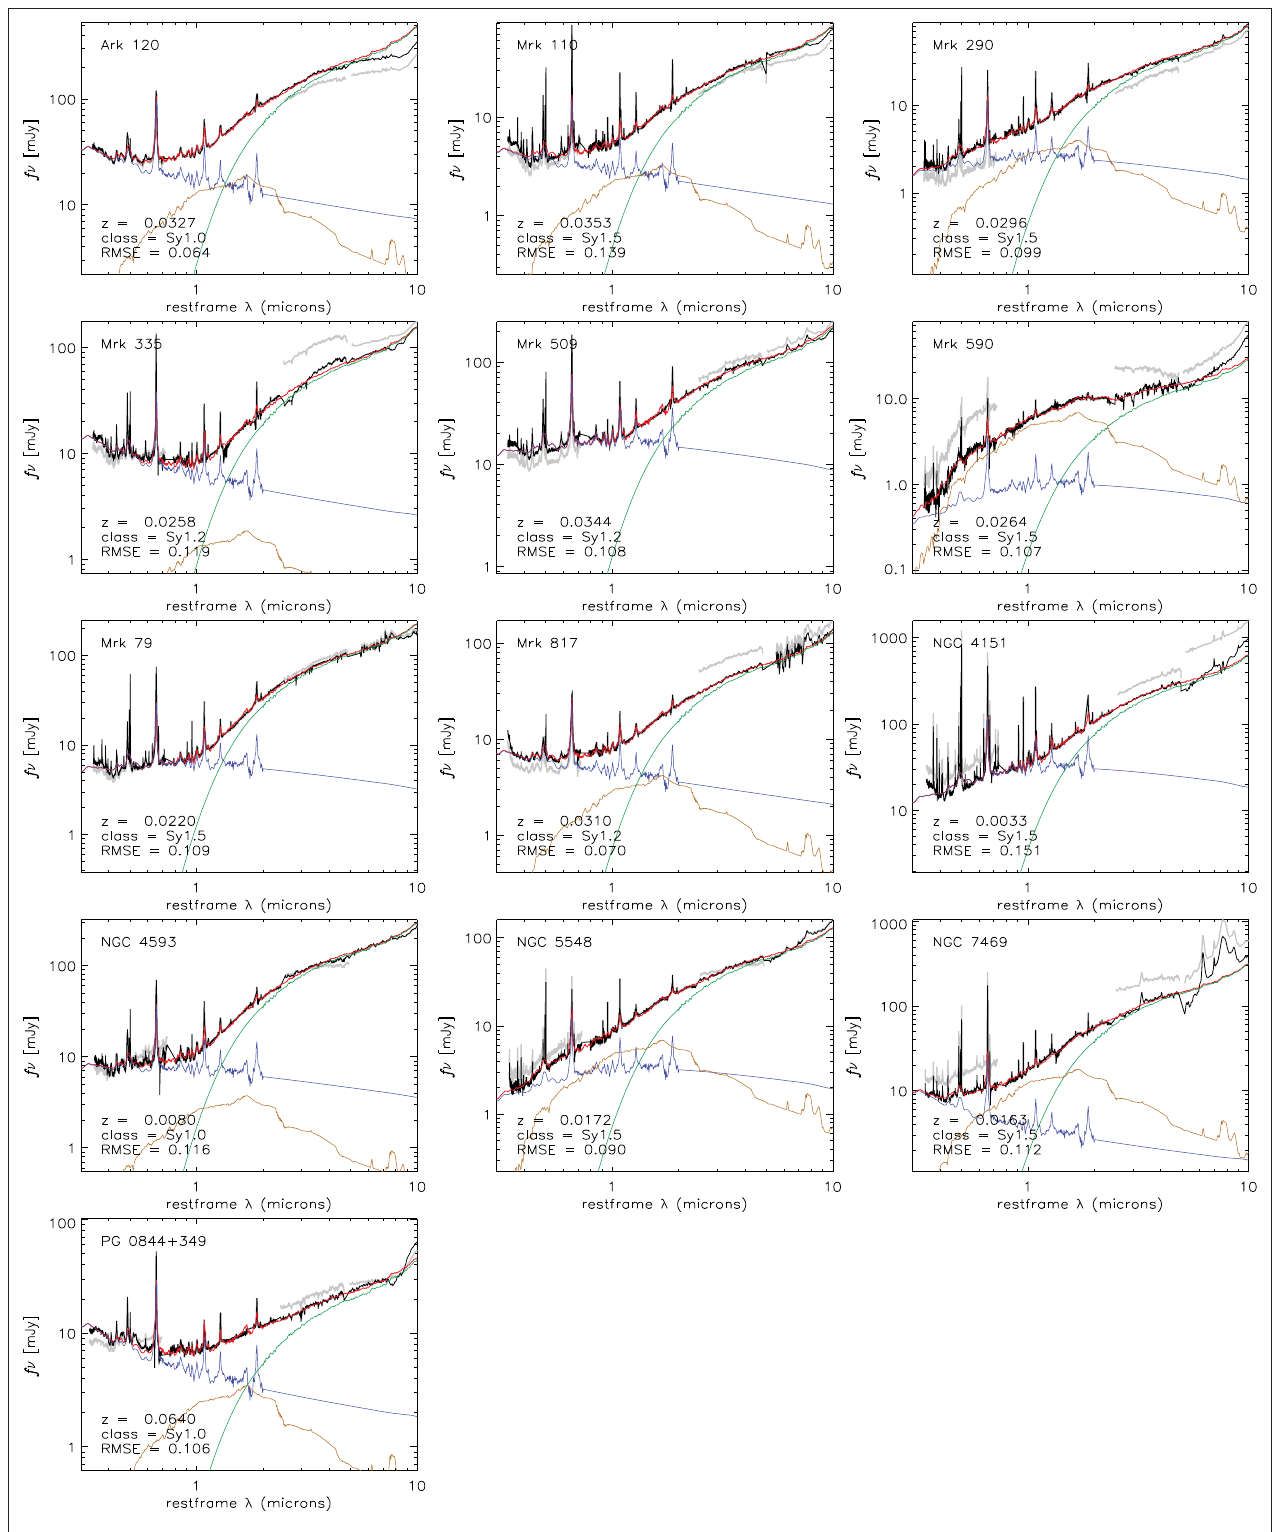
FIGURE 4 | Spectral decompositions of local type 1 AGN. The gray thick lines represent spectral segments from observations with FAST, SpeX, AKARI, and IRS. The black line is the stitched spectrum. The red line is the best fitting disk+dust+stellar model for the stitched spectrum, while the blue, green, and yellow lines represent the individual disk, dust, and host galaxy